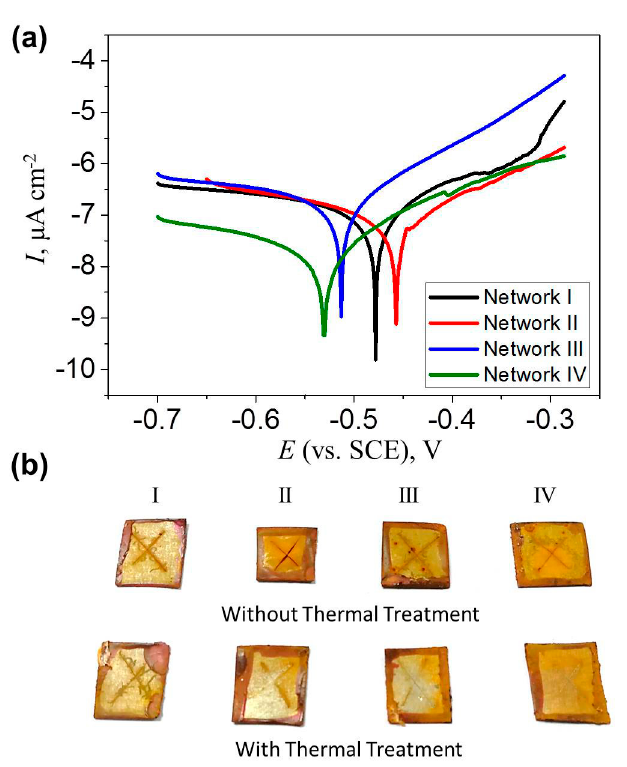
Figure 8. ( a ) Tafel plots of Networks I–IV; ( b ) Photos of the coated steel plates without and with thermal treatment after immersion in NaCl solution for 120